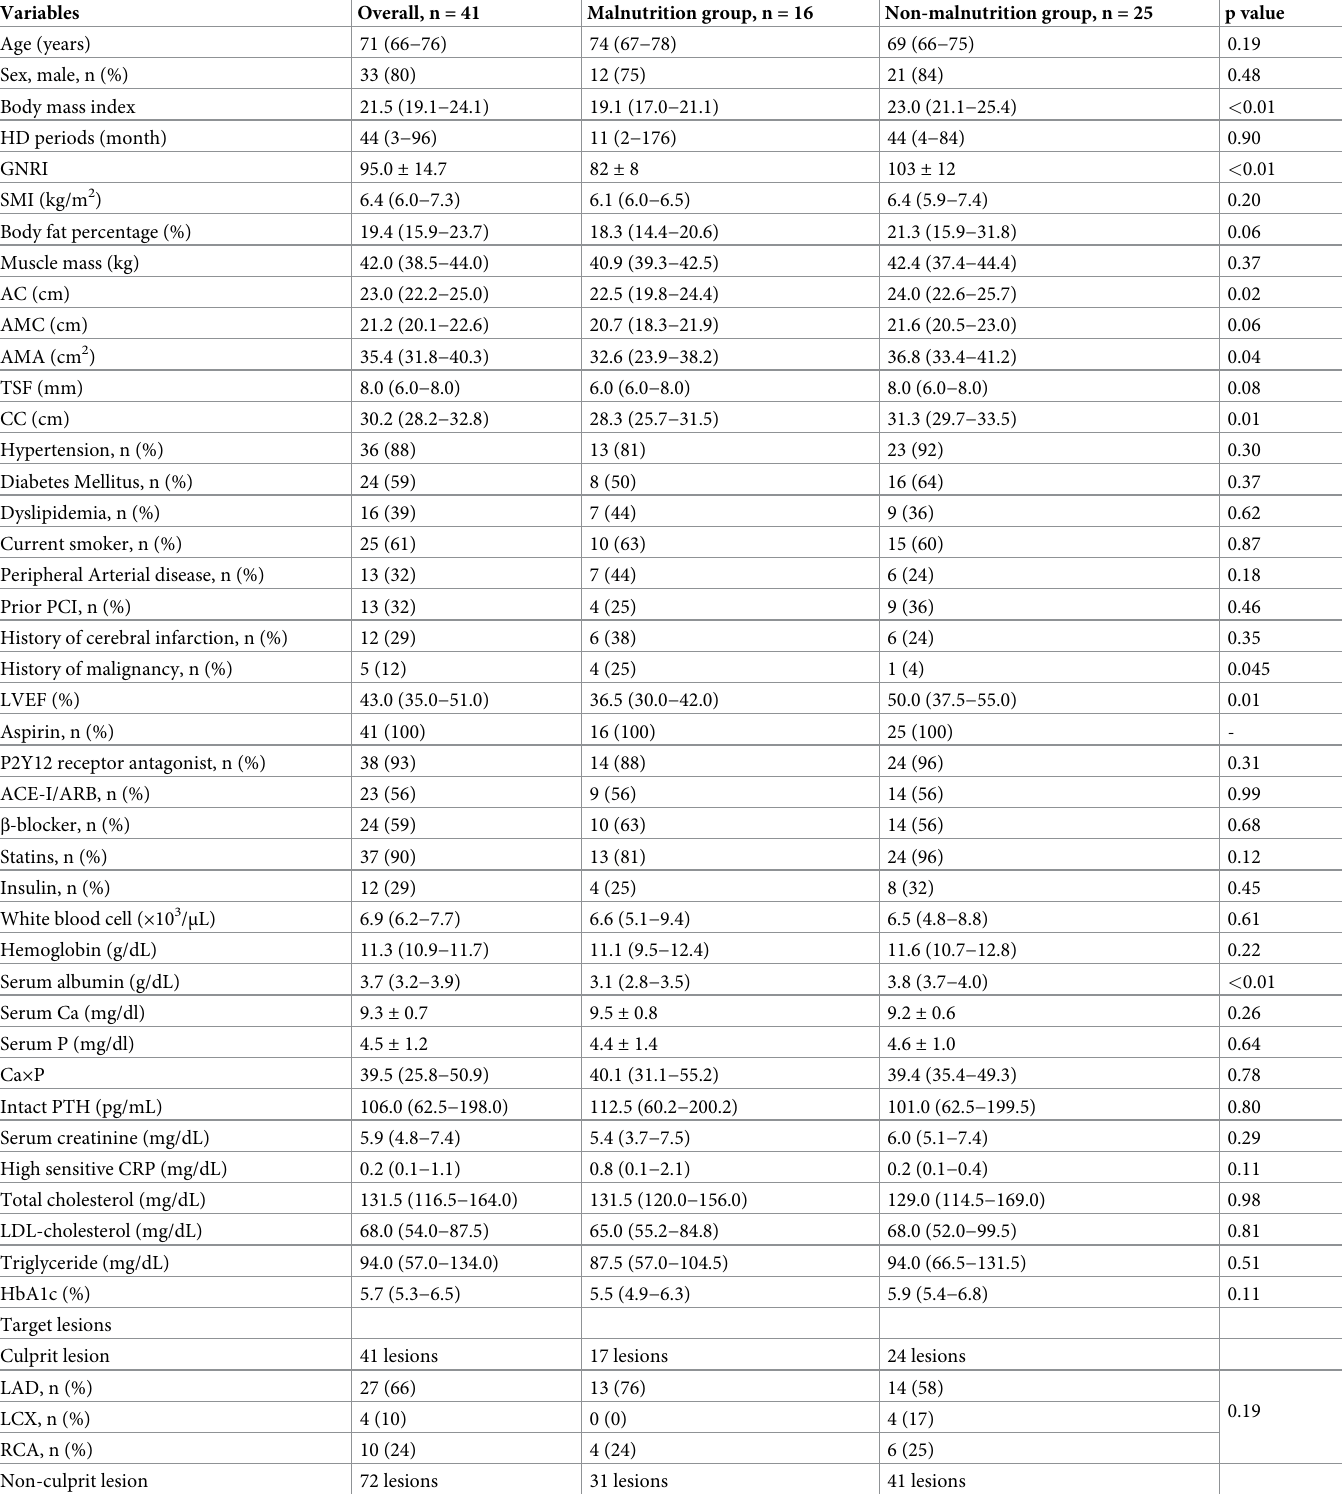
Table 1. Baseline clinical characteristics of study